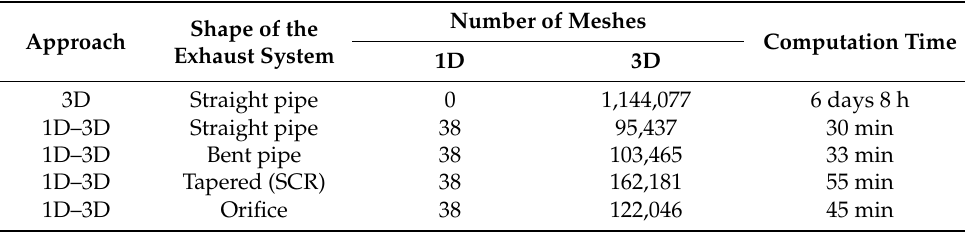
Table 3. Comparison of the number of meshes and computation time according to the approach and the shape of the exhaust